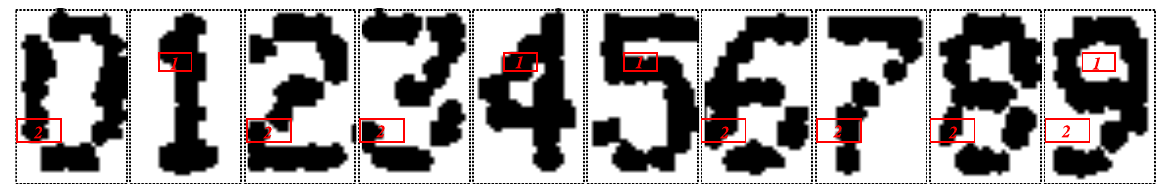
Fig. 13. Individual images with grids.